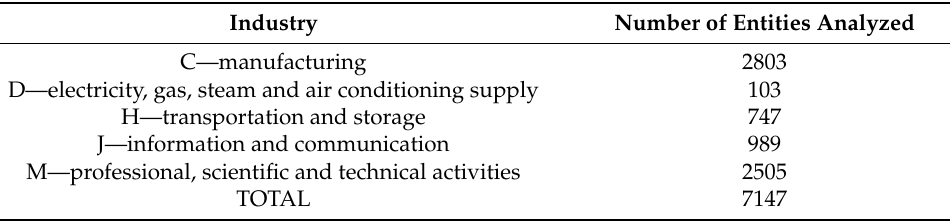
Table 2. Number of analyzed entities according to different